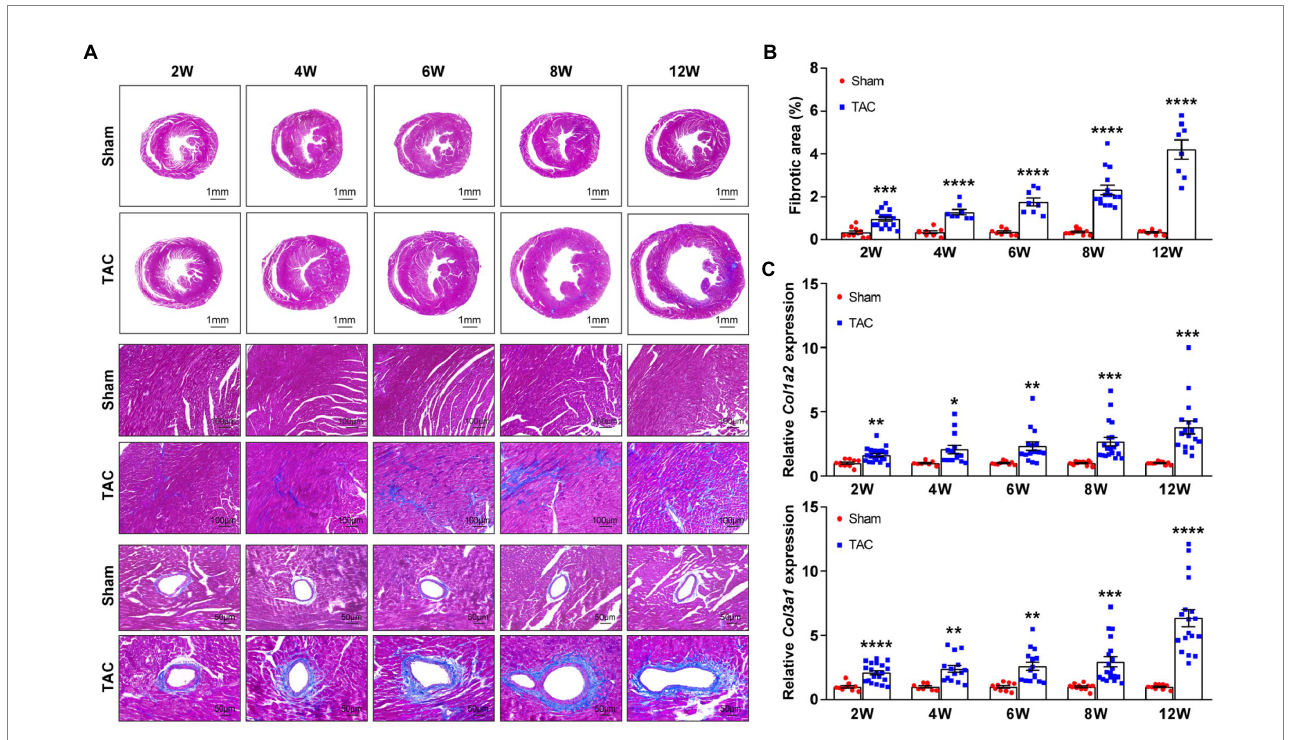
FIGURE 9 Time-series cardiac fibrosis induced by TAC. (A) Representative images of Masson’s trichrome staining of heart sections (top). (B) Quantification of the fibrotic area (bottom), n = 8~15. (C) Expression of Col1a2 and Col3a1 in mouse heart was detected by qPCR at various times upon surgery, n = 8~20. Unpaired t -test for two-group comparisons, * p < 0.05, ** p < 0.01, *** p < 0.001, **** p < 0.0001 vs. corresponding